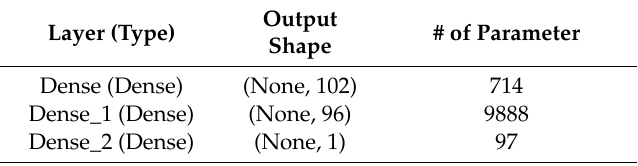
Table 1. Structure of the neural network (NN) after hyper-parameter